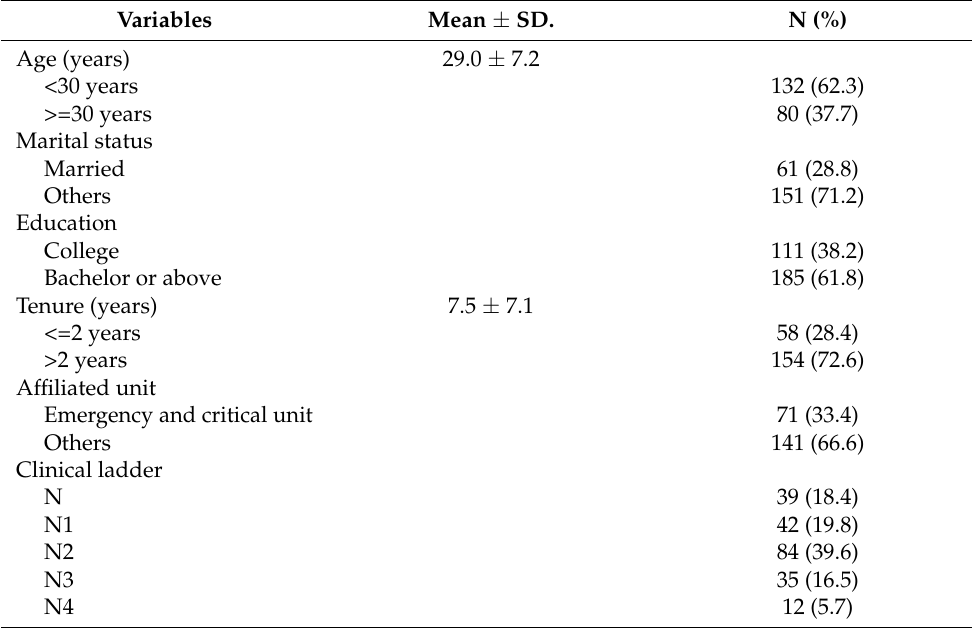
Table 1. Demographic characteristics of the study